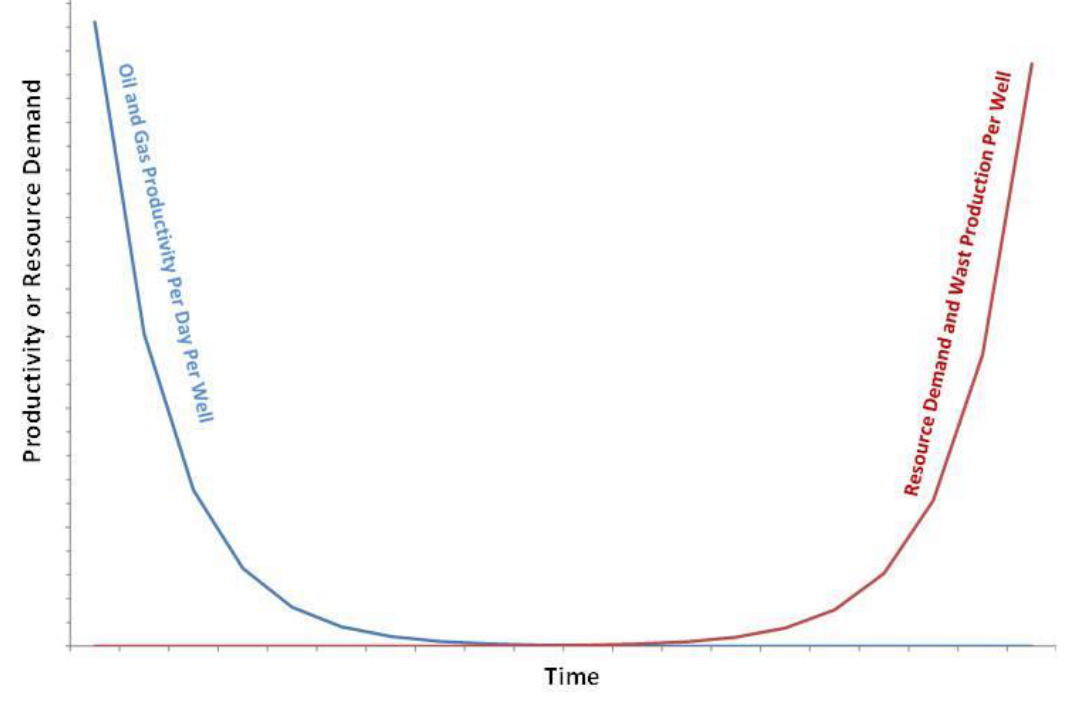
Figure 2. Theoretical relationship between resource demand and unconventional oil/gas production over time.